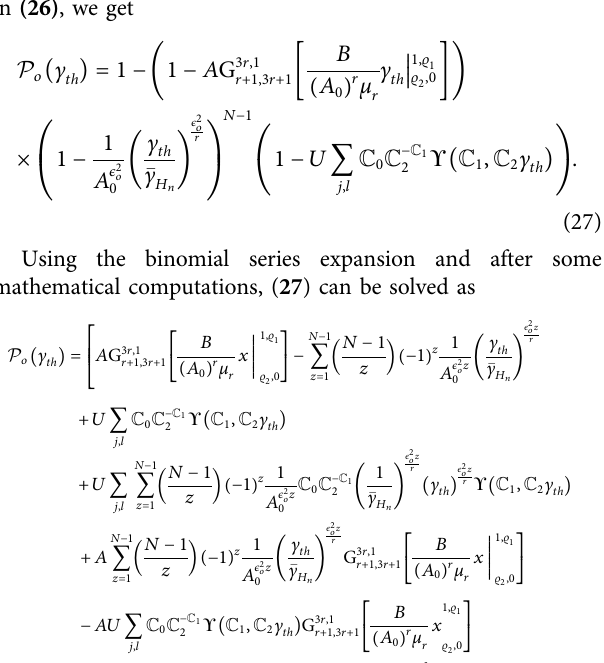
TABLE 2 | Selection parameters for various modulation schemes (Zedini et al.,